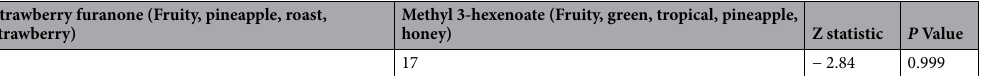
Table 4. Duo trio sensory test result between strawberry furanone (14,19 neuron) and methyl 3-hexenoate (14,18 neuron)- ethyl hexanoate (10,12 neuron) as a reference